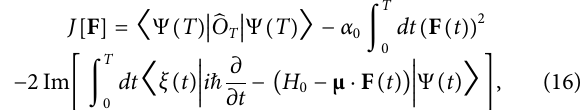
Frontiers in Physics |